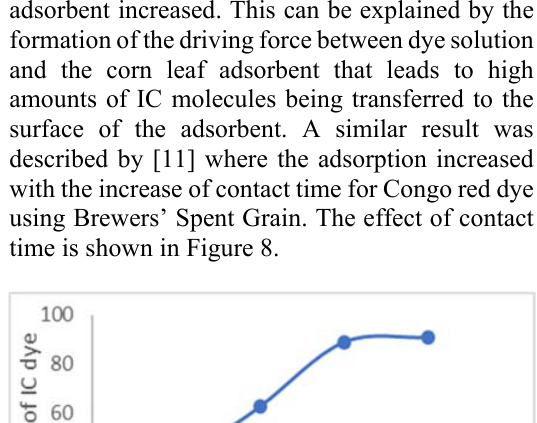
Fig. 6 The effect of initial dye concentration on the removal efficiency of IC dye at 30 o C and contact time of 4 days.